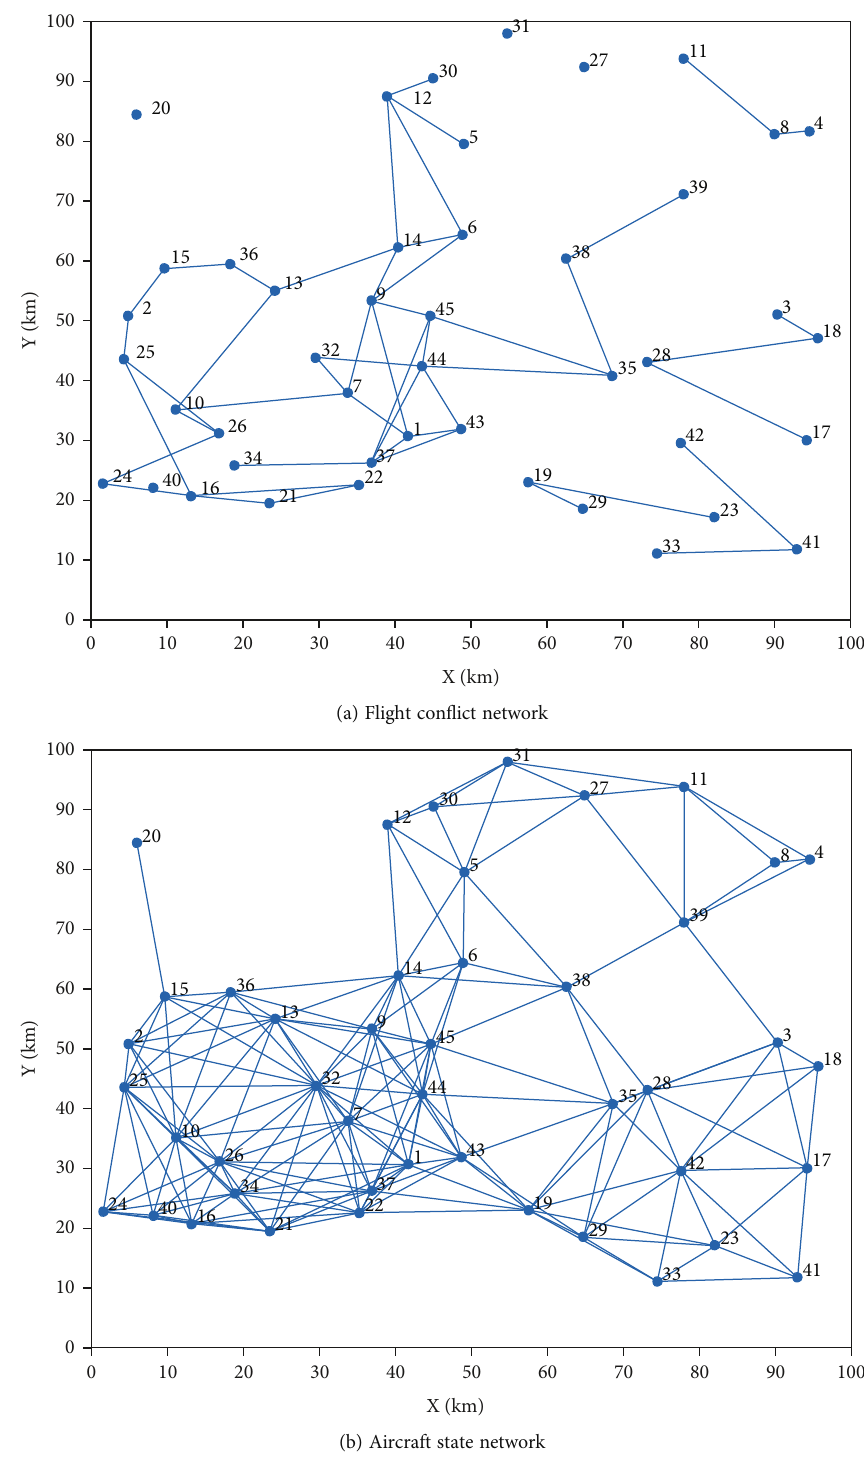
Figure 12: Network comparison